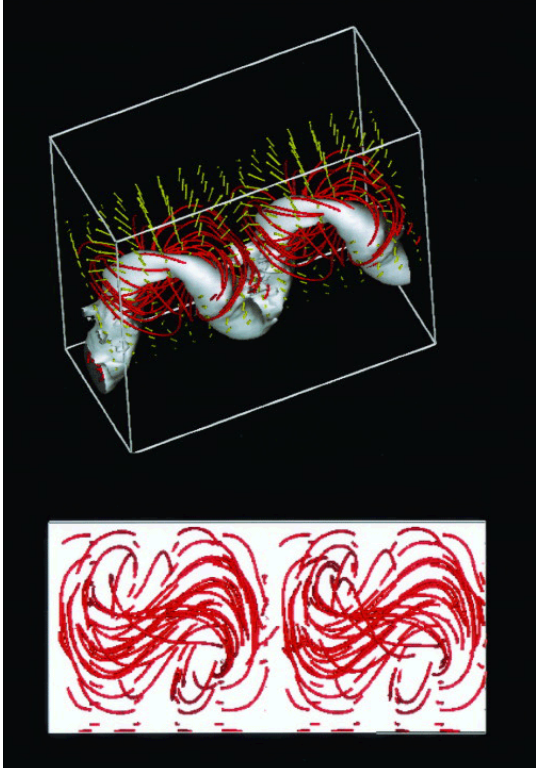
Figure 39: 3D rendering of a simulation of a twisted magnetic flux rope undergoing the helical kink instability. While the helical instability is developing, the crests of the flux tube are emerging into the idealized (initially plane-parallel) model atmosphere. Image reproduced with permission from Matsumoto et al. (1998), copyright by